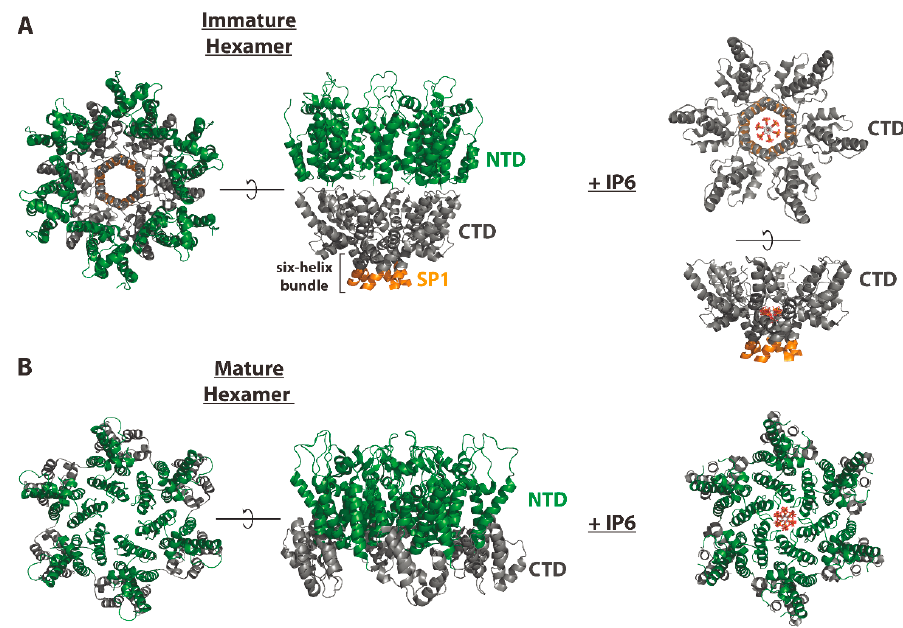
Figure 4. IP6 binds to immature Gag hexamers and mature CA hexamers. ( A ) The CA-CTD (gray) and SP1 (orange) of Gag facilitate the formation of hexamers that assemble into the immature Gag lattice. IP6 promotes Gag assembly by binding at the center of Gag hexamers just above the six-helix bundle, a key structural element consisting of the C-terminal amino acid residues of CA and the N-terminal amino acid residues of SP1. ( B ) Mature CA hexamer formation is driven primarily by CA-NTD / CA-NTD interactions, though CA–NTD / CA–CTD interactions also contribute. IP6 promotes mature hexamer and capsid assembly by binding to a central pore within CA hexamers responsible for facilitating nucleotide import (figures generated using PDB accessions 4USN, 5I4T, 6BHR, and 6ES8).